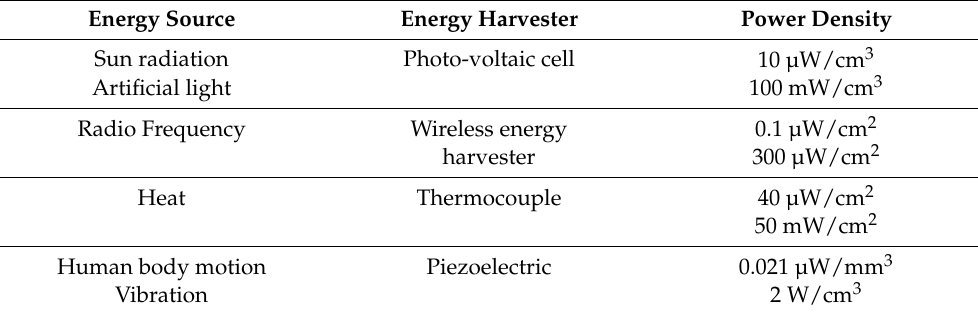
Table 2. Relevant energy harvesting for MIoT system [4].